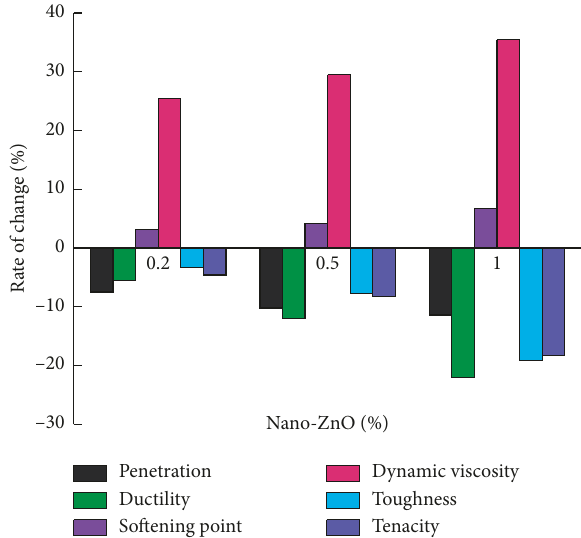
Figure 4: The change rate of evaluation index